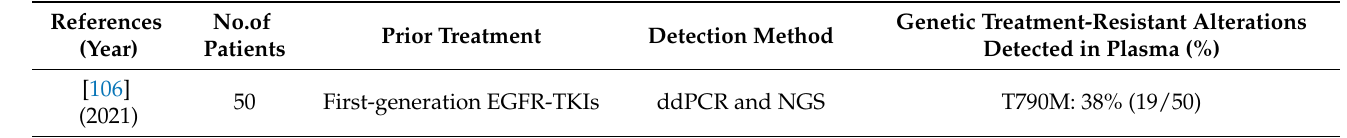
Table 2. Literature data on the genetic alterations detected in plasma during EGFR-TKI